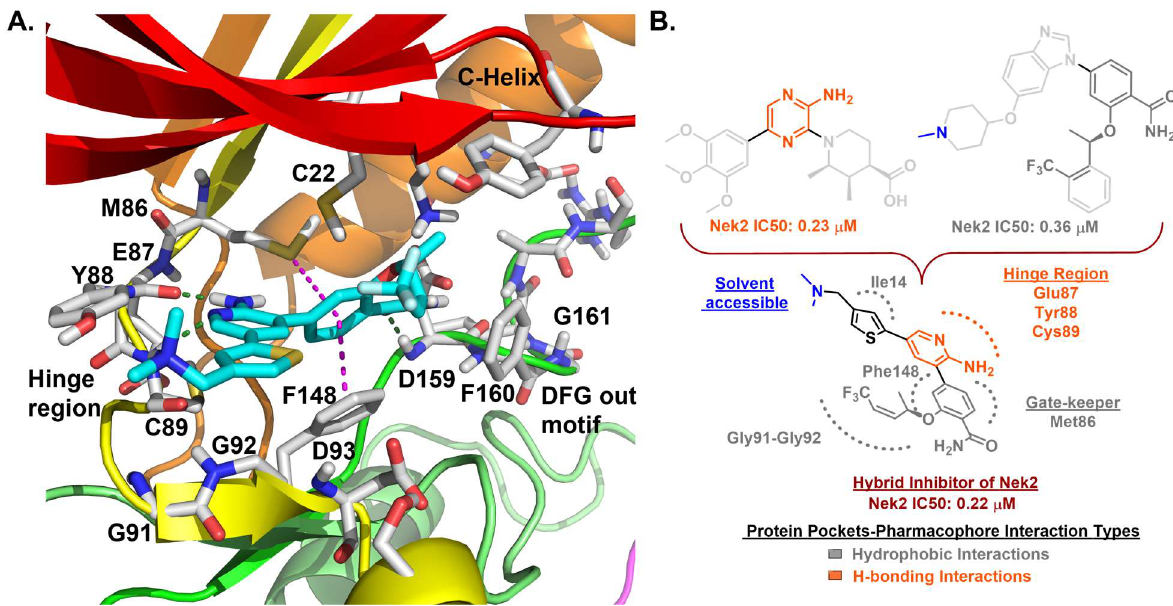
Figure 11. ( A ) Crystal structure of compound 7 bound Nek2 which shows the DFG-out conformation of the protein. Key H-bond and hydrophobic interactions are shown as green and purple dotted lines, respectively (PDB code: 4AFE). ( B ) The amalgamation of 2-aminopyrazine- and benzimidazole-type ligands leads to the construction of a new inhibitory motif for targeting Nek2 with improved efficacy.